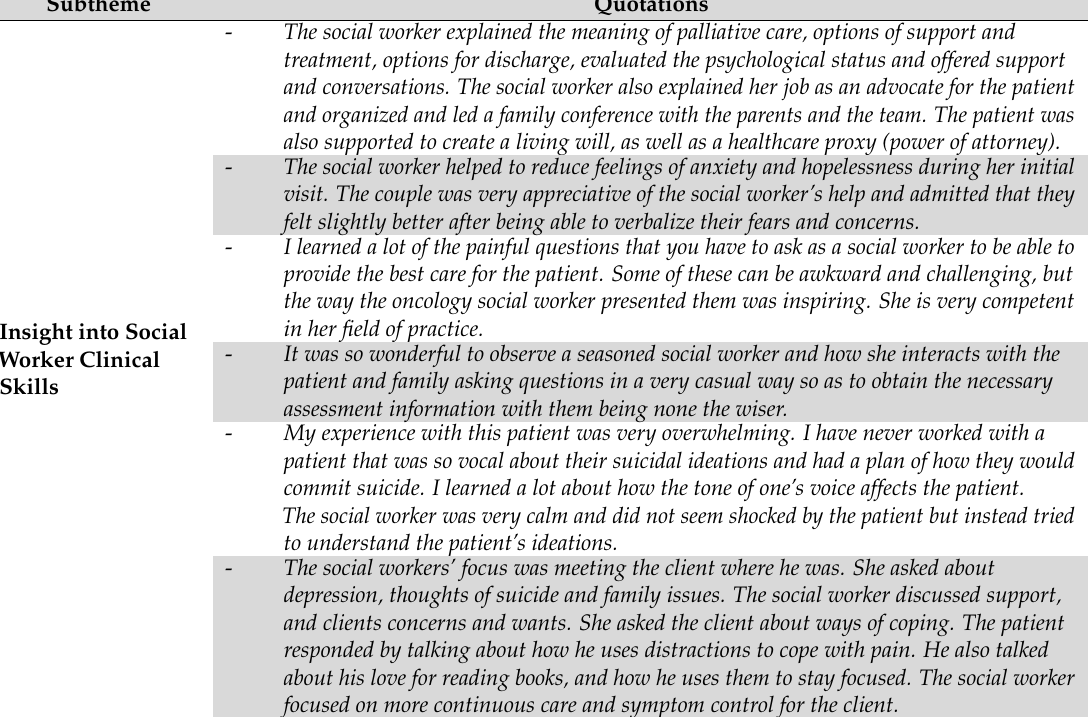
Table 3. Quotes related to the subtheme of insight into social worker clinical skills.